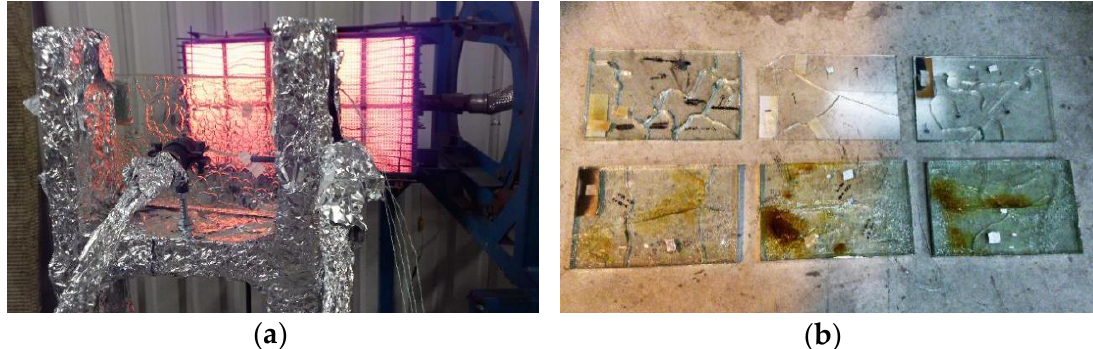
Figure 3. Thermal experiments on MG and LG specimens: ( a ) test setup (with an exposed LG sample) and ( b ) typical damage scenarios for the failed specimens, at the end of the radiant heating tests (Copyright @ Daniel Honfi).